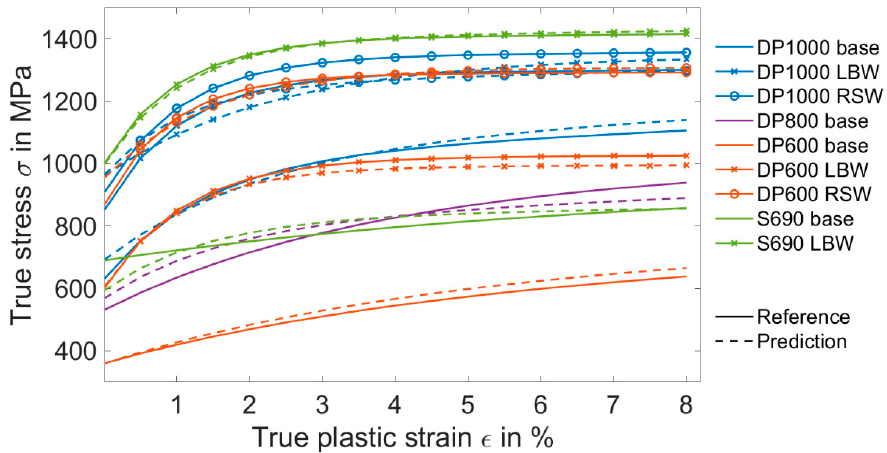
Figure 8. Comparison between the output of the ANN trained with the force–indentation curves and the reference values from Table 4.